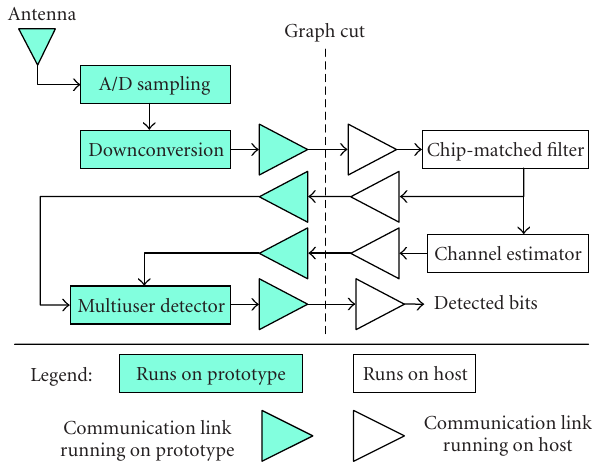
Figure 7: The directed graph of a CDMA baseband receiver after partitioning and communication link insertion.